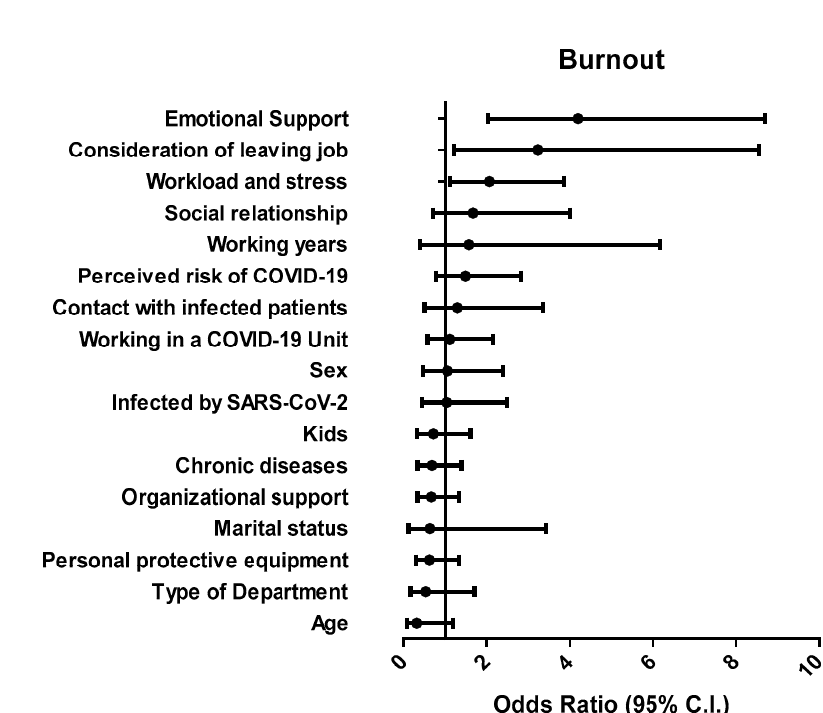
Figure 2. Forest plot showing adjusted odds ratio for the frequency distribution analysis of burnout.